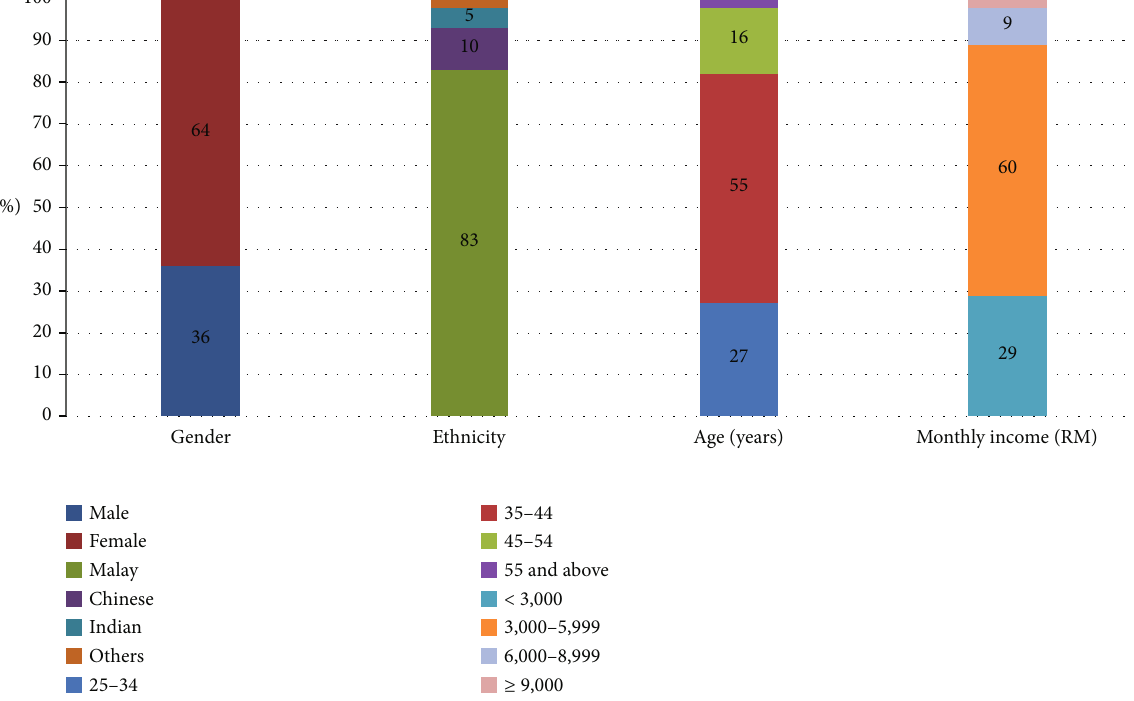
Figure 5: Demographic pro fi le of